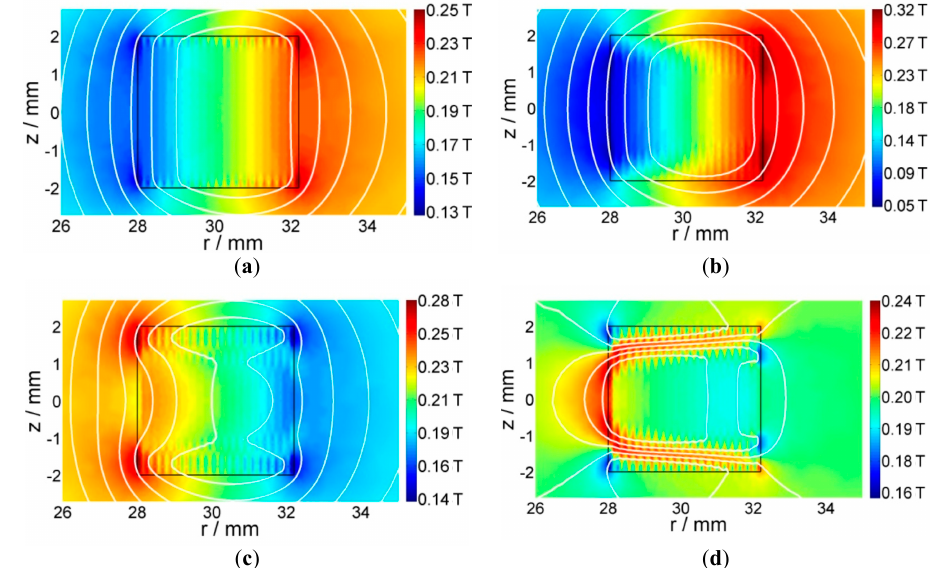
Figure 7. Magnetic field distribution and flux line plot of a 20-turn coil with an external field of − 0.2 T. The white contour lines represent the directions. ( a ) Ramping up to 30 A; ( b ) ramping up to 110 A; ( c ) ramping down to − 30 A; ( d ) ramping up to 0. The rectangle outlined in black represents the region occupied by superconductors.